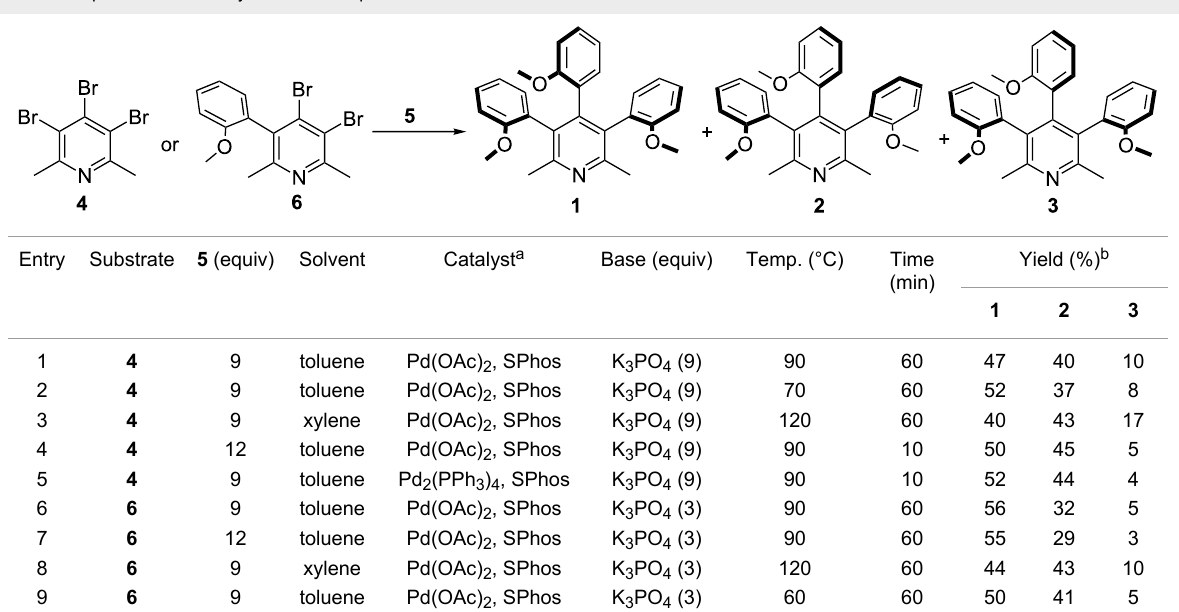
Table 2: Optimization of the synthesis of compounds 1 – 3